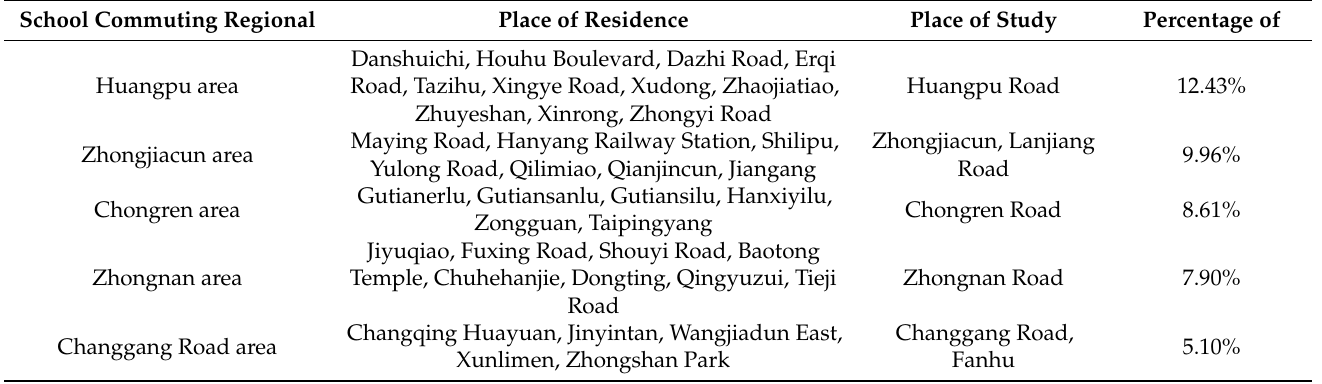
Table 3. Typical school commuting regional